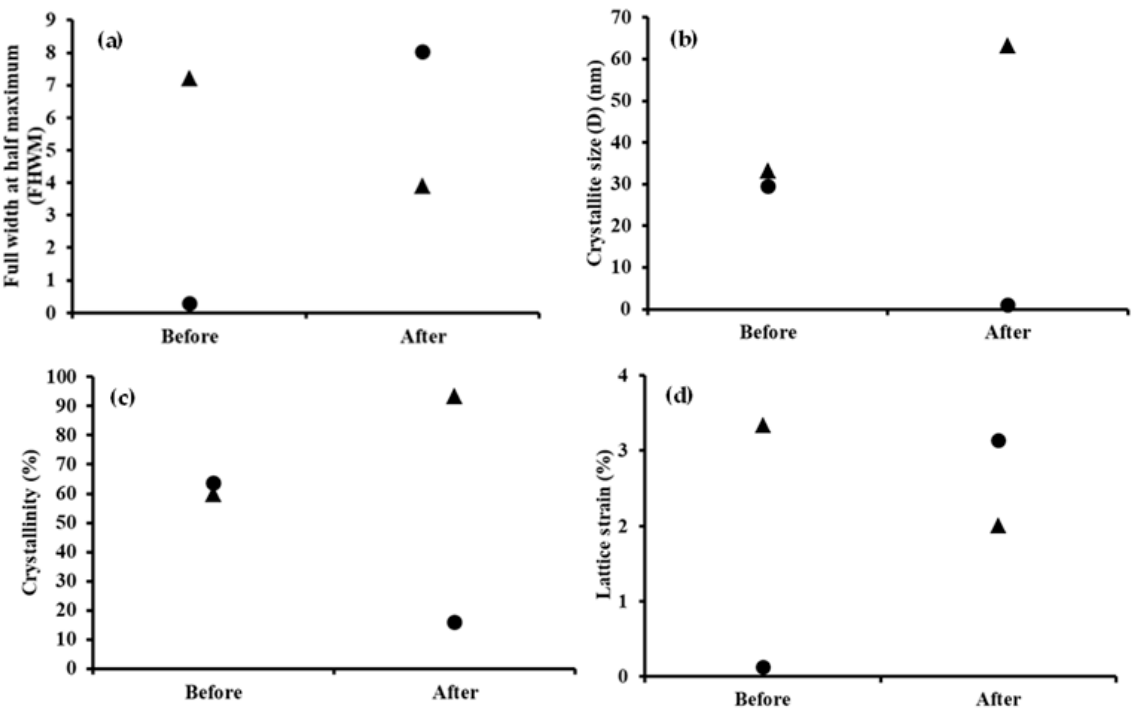
Figure 13. Parameters of: ( a ) FHWM, ( b ) crystallite size, ( c ) crystallinity and ( d ) lattice strain, before and after exposure (noted by the marks for I ‐ AMP ( ● ) and N ‐ AMP ( ▲ ), respectively).